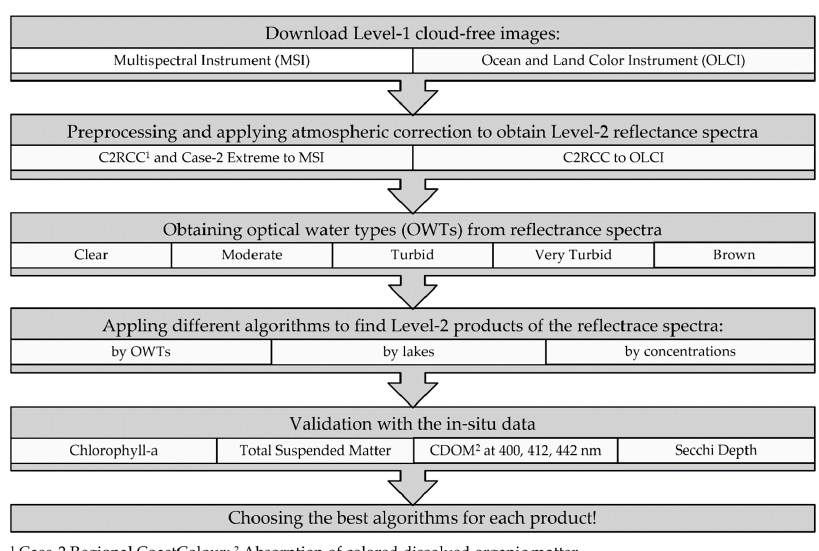
Figure A1 . The flowchart of the different steps of the validation process. Figure A1. The flowchart of the di ff erent steps of the validation